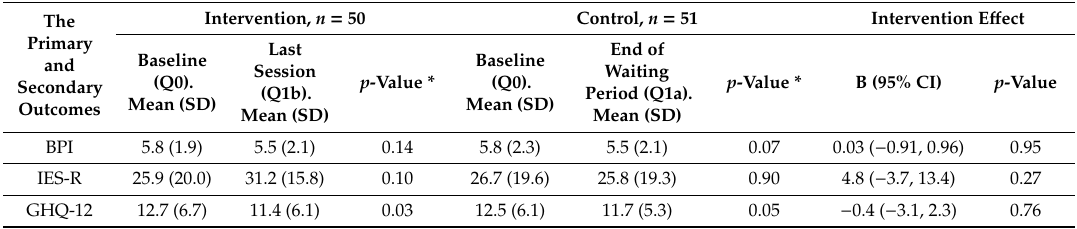
Table 2. E ff ect of PAAI intervention on the primary and secondary outcomes. Intention to treat analyses using linear mixed